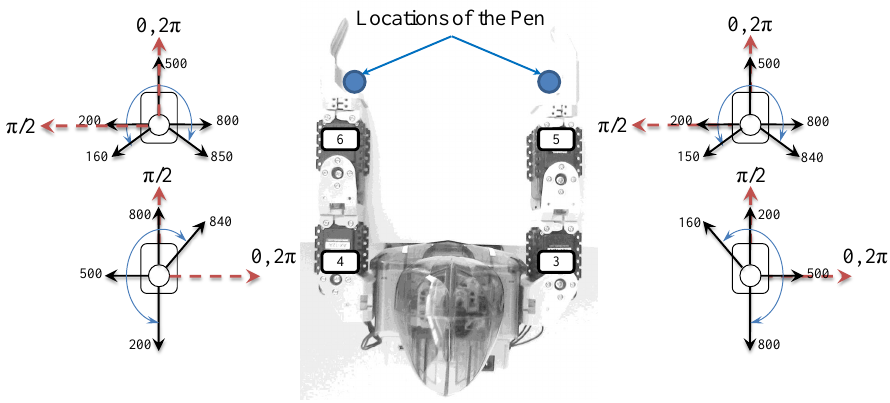
Figure 9. Positions of the Bioloid’s servomechanisms and reference